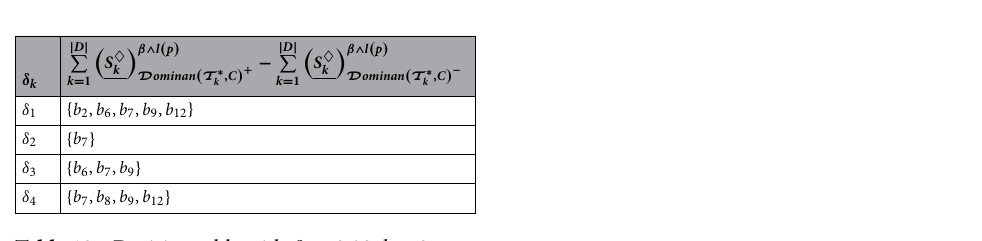
Table 13. Decision table with β = 0.90, l = 0